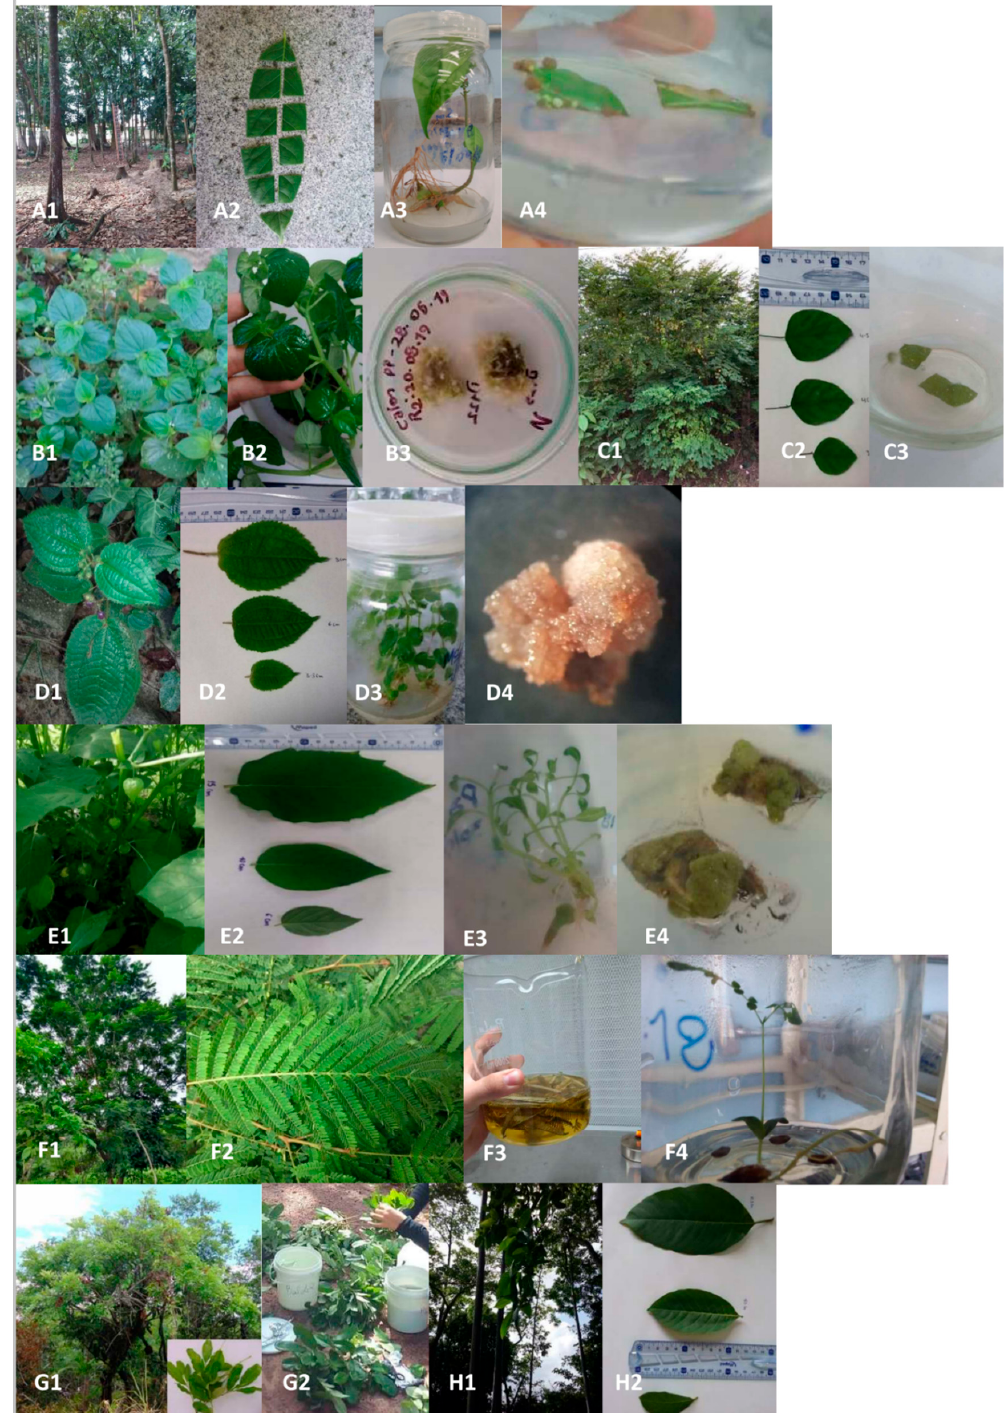
Figure 3. Establishment of in vitro leaf tissue culture for eight plant species: from leave samples collected in natura to in vitro cultures. Swietenia macrophylla ’s trees ( A1 ), leaf and explants ( A2 ), axenic plantlets ( A3 ) and calli ( A4 ); Peperomia pellucida ’s plants and leaves ( B1 , B2 ), callus ( B3 ); Phyllantus brasiliensis ’s plant ( C1 ), leaves ( C2 ) and explants on solid medium ( C3 ); Clidemia hirta ’s plant ( D1 ), leaves ( D2 ), axenic plantlets ( D3 ) and callus ( D4 ); Physalis angulata ´s plant ( E1 ), leaves ( E2 ), axenic plantlets ( E3 ) and calli ( E4 ); Stryphnodendron pulcherrimum ´s tree ( F1 ), leaves ( F2 ), surface sterilization process ( F3 ), axenic plantlets ( F4 ); Vatairea guianensis ´s tree and leaves ( G1 ) precleaning step of the leaves ( G2 ); Calycophyllum spruceanum ´s tree ( H1 ) and leaves ( H2 ).